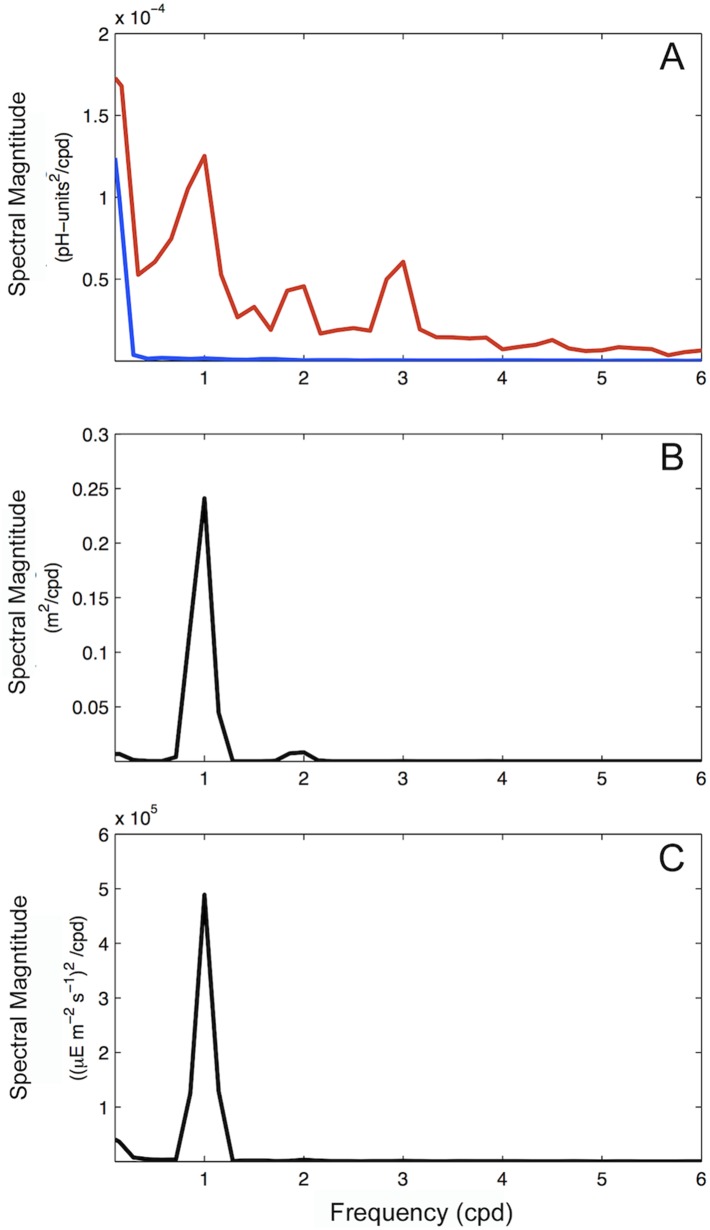
Spectra for pH, tide, and surface irradiance from eastern McMurdo Sound.pH spectra (A) for Hut Point (blue) and Cape Evans (red). Tide spectra (B) are from Cape Evans. Surface irradiance spectra (C) were measured at Arrival Heights. Frequency is in the units of cycles per day.